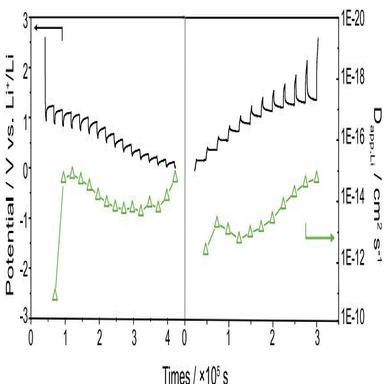
GITT test results containing the changes of (Dapp,Li) and variation curve along with the GCD processes.